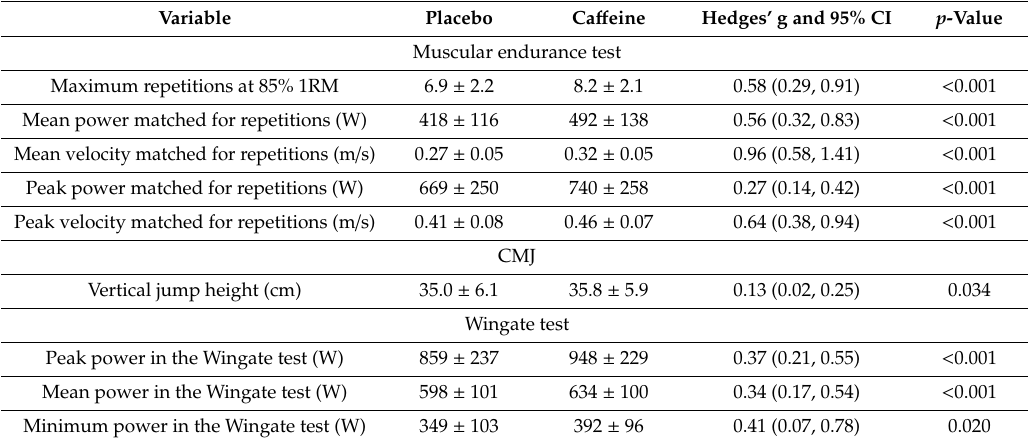
Figure 1. The e ff ects of ca ff eine vs. placebo on peak power (upper left section), peak velocity (lower left section), mean power (upper right section), and mean velocity (lower right section) in the bench press with 25%, 50%, 75%, and 90% of one repetition maximum (1RM). Data are presented as mean ± standard deviation. * denotes significant di ff erences between the conditions. Table 2. E ff ects of ca ff eine ingestion on performance in the muscular endurance test, countermovement jump, and Wingate: results from a series of one-way repeated measures analyses of variance. Ca ff